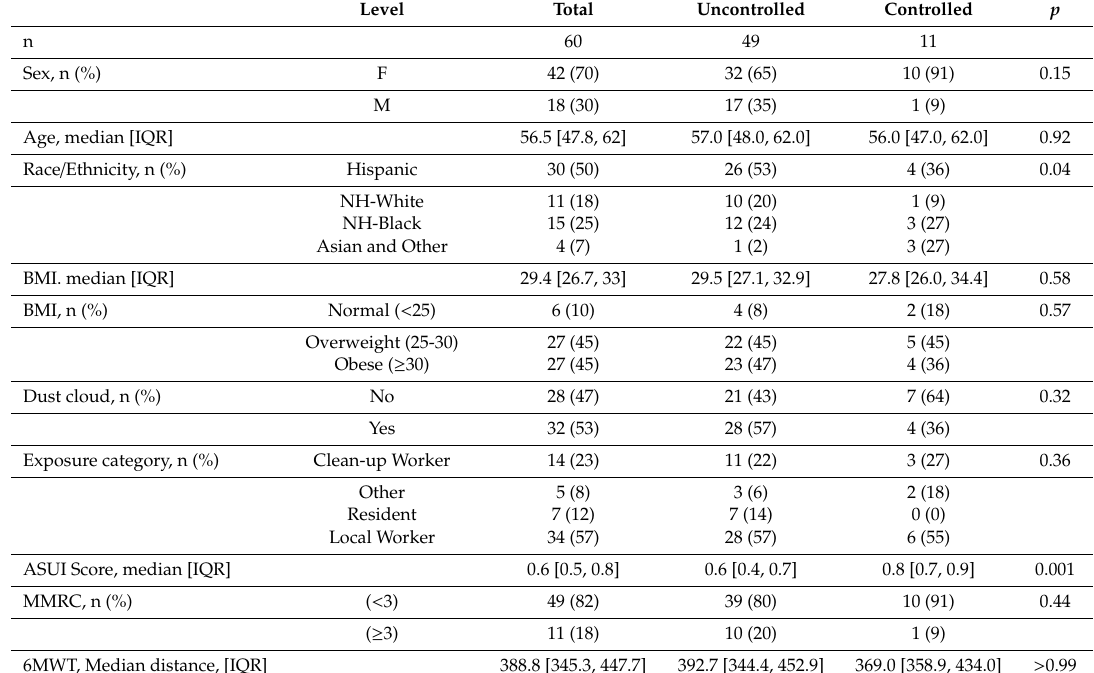
Table 1. Demographic, clinical, and exposure characteristics of patients who were uncontrolled at V1 (n = 60).